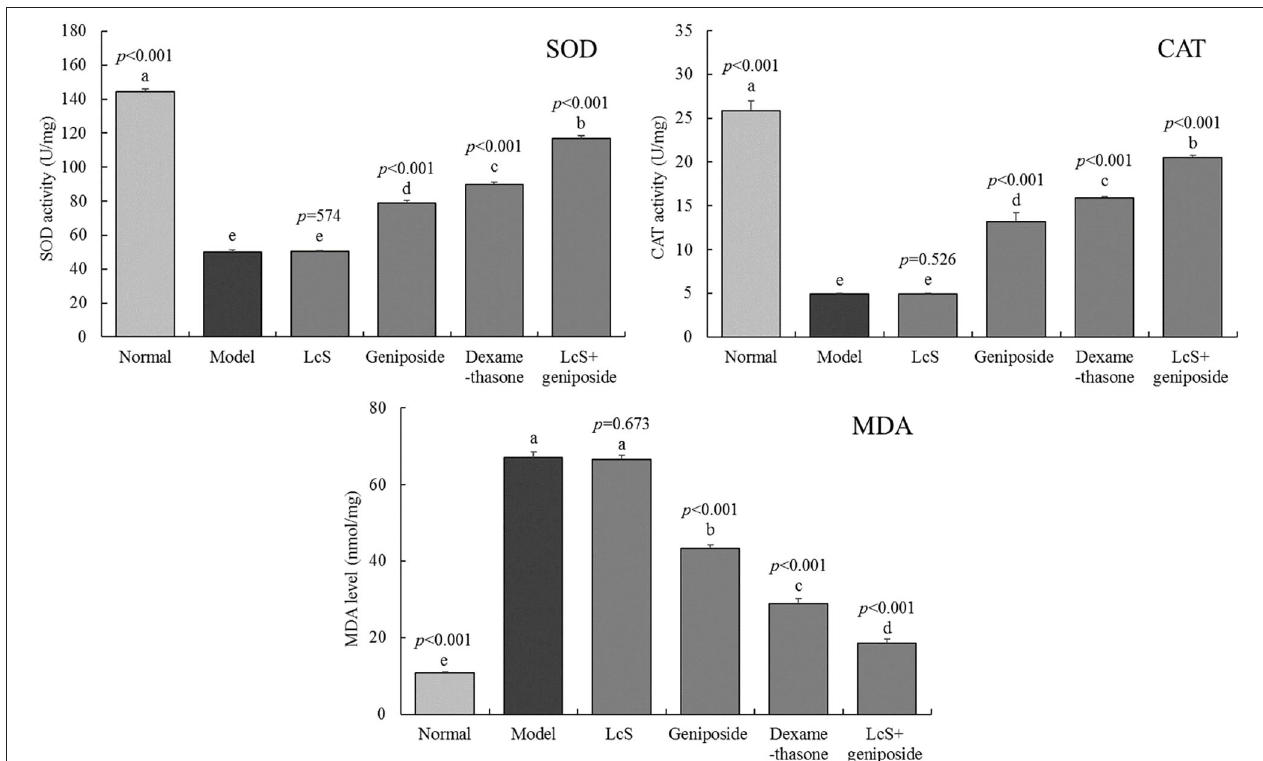
FIGURE 5 | Superoxide dismutase (SOD), catalase (CAT), and malondialdehyde (MDA) levels of the hippocampus of mice with sepsis on the seventh day ( n = 8). The mean values are tabulated with mean ± standard deviation, and the p -value is the relative situation of the corresponding group to the model group. Normal: untreated mice, model: mice with induced sepsis; LcS: 5 × 10 7 CFU/kg-treated mice with sepsis; geniposide: 50 mg/kg geniposide-treated mice with sepsis; dexamethasone: 1 mg/kg dexamethasone-treated mice with sepsis; LcS + geniposide: 5 × 10 7 CFU/kg LcS and 50 mg/kg geniposide-treated mice with sepsis. a − e Mean values with different letters over the bar are significantly different ( P < 0.05) according to Tukey’s honestly significant difference